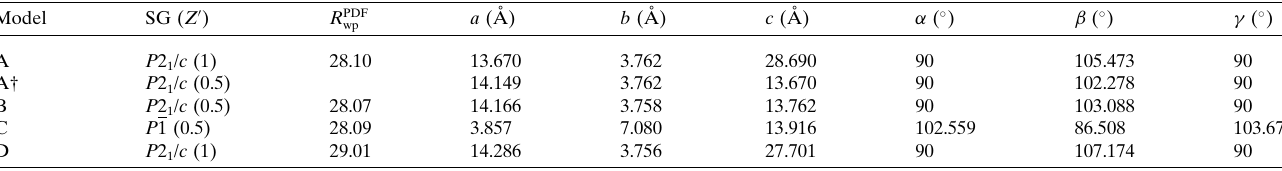
Table 6 Crystal structural models obtained by fit to the PDF (298 K data, rigid molecules).